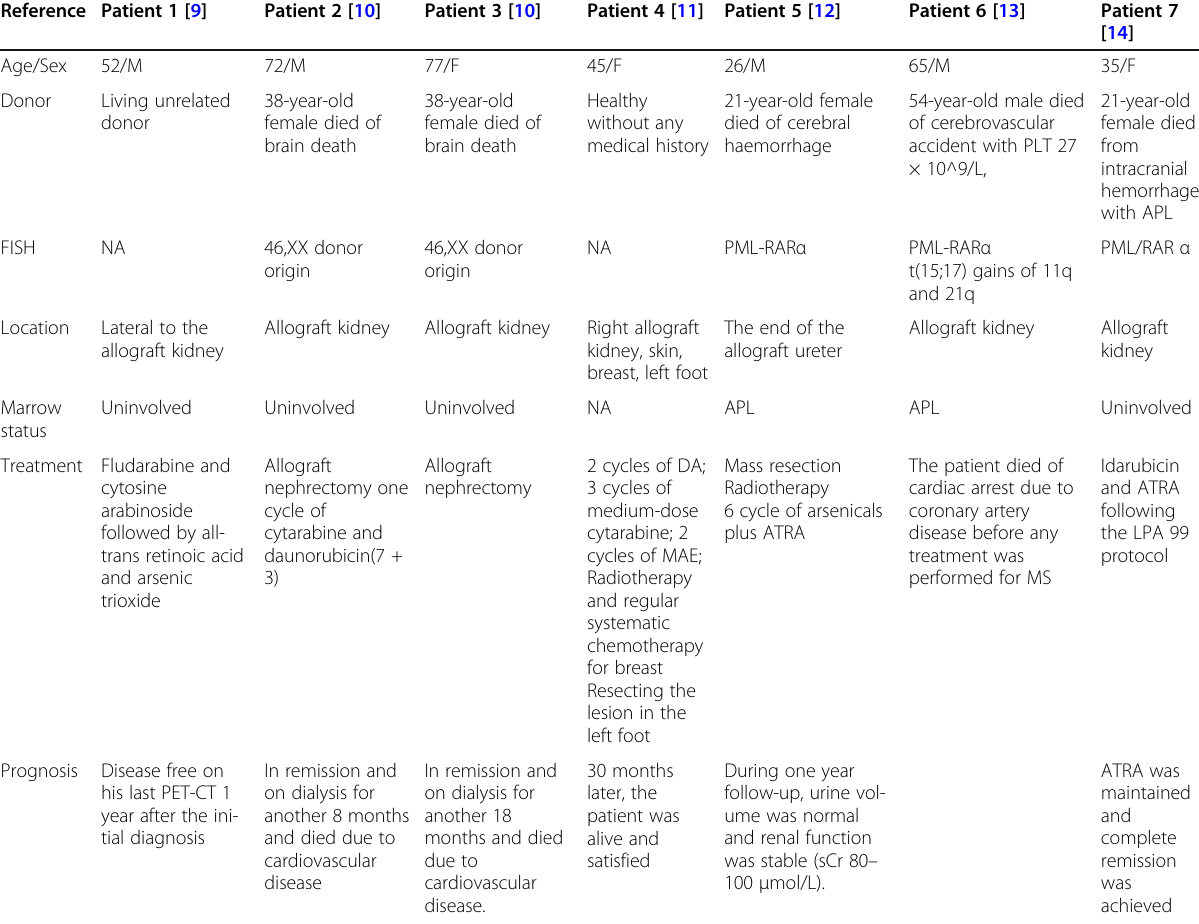
Table 1 Baseline disease characteristics, treatments, and outcomes of MS cases following renal transplantation in the literature